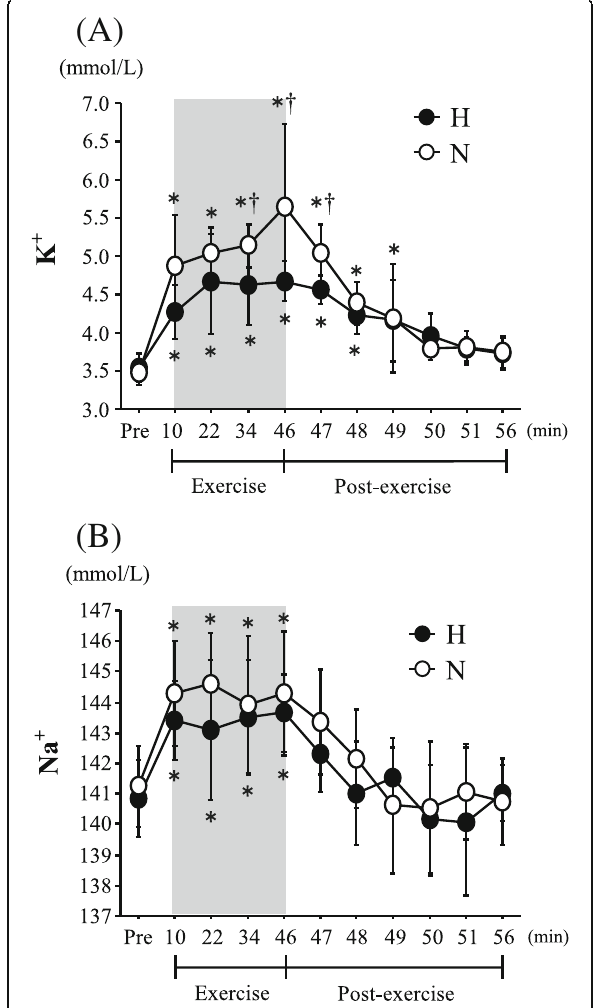
Fig. 4 Changes in blood potassium (K + ) ( a ) and sodium (Na + ) ( b ) concentrations. Values are means ± SE. The shaded box indicates the duration of exercise. *Significant difference compared with Pre. † Significant difference between the N and H